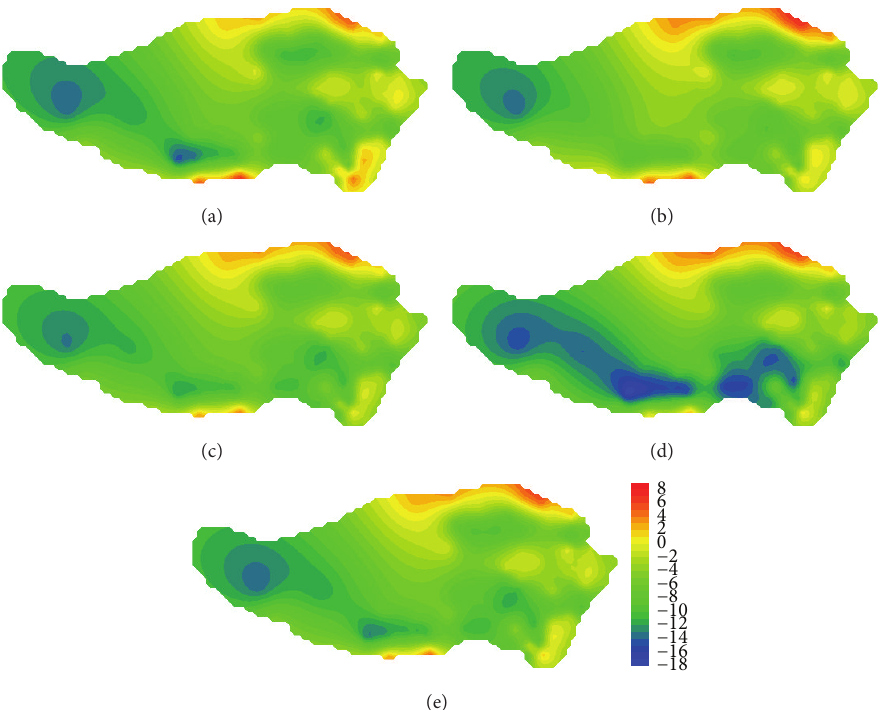
Figure5:ComparisonofthevaluesoftemperatureontheTibetanPlateauinreferenceperiodbetweenGFCM21’ssimulationandobservation: (a) spring; (b) summer; (c) fall; (d) winter; (e) annual.